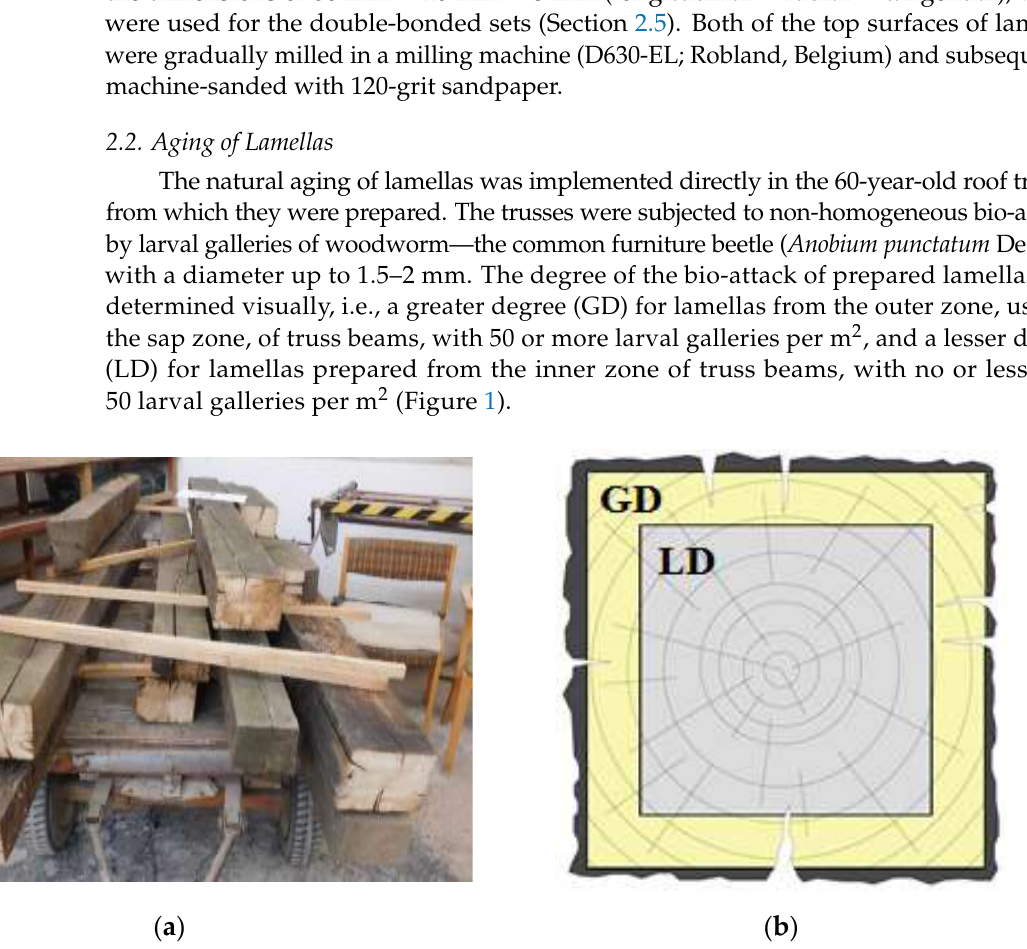
Figure 1. Sixty-year-old roof trusses bio-attacked by larval galleries of Anobium punctatum ( a ), and scheme of prism used for the lamella preparation with a greater degree (GD) and lesser degree (LD) of bio-attack ( b ).